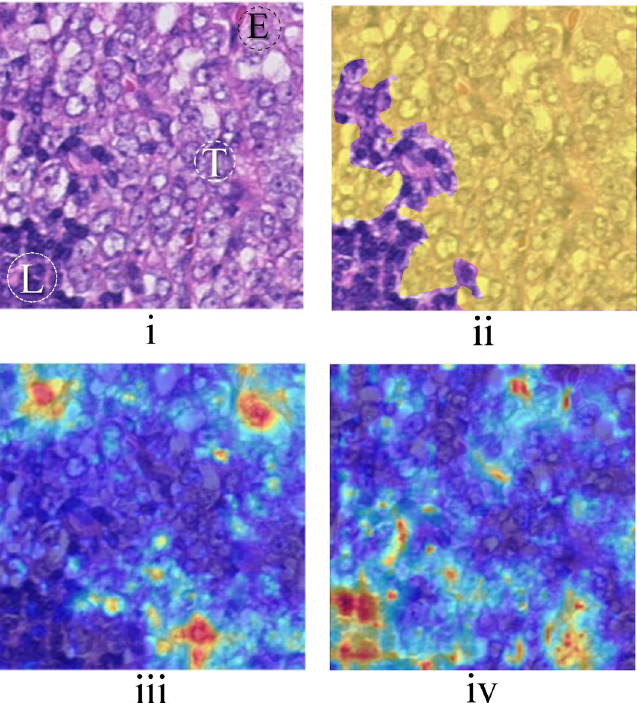
Figure 6. The result of training using scenario 1 and scenario 2 : ( i ) an OOD tumorous patch (from hospital 3) with different anatomical structures, Ⓣ : Tumor cells, Ⓛ : Lymphocyte, Ⓔ : Erythrocyte. ( ii ) Expert annotation for tumorous regions. ( iii ) GradCAM heatmap for the model trained using scenario 2 which correctly classified the patch, ( iv ) GradCAM heatmap for the model trained using scenario 1 which misclassified the patch as a healthy